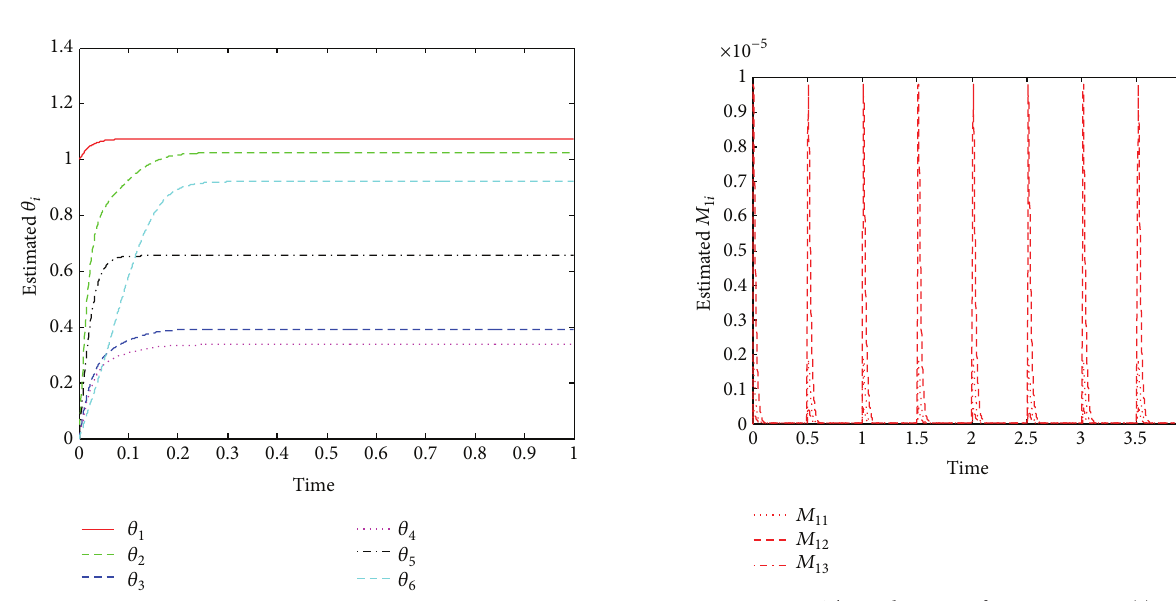
Figure 3: The curve of control 𝜃 𝑖 with 𝑖 = 1, ...,6 .